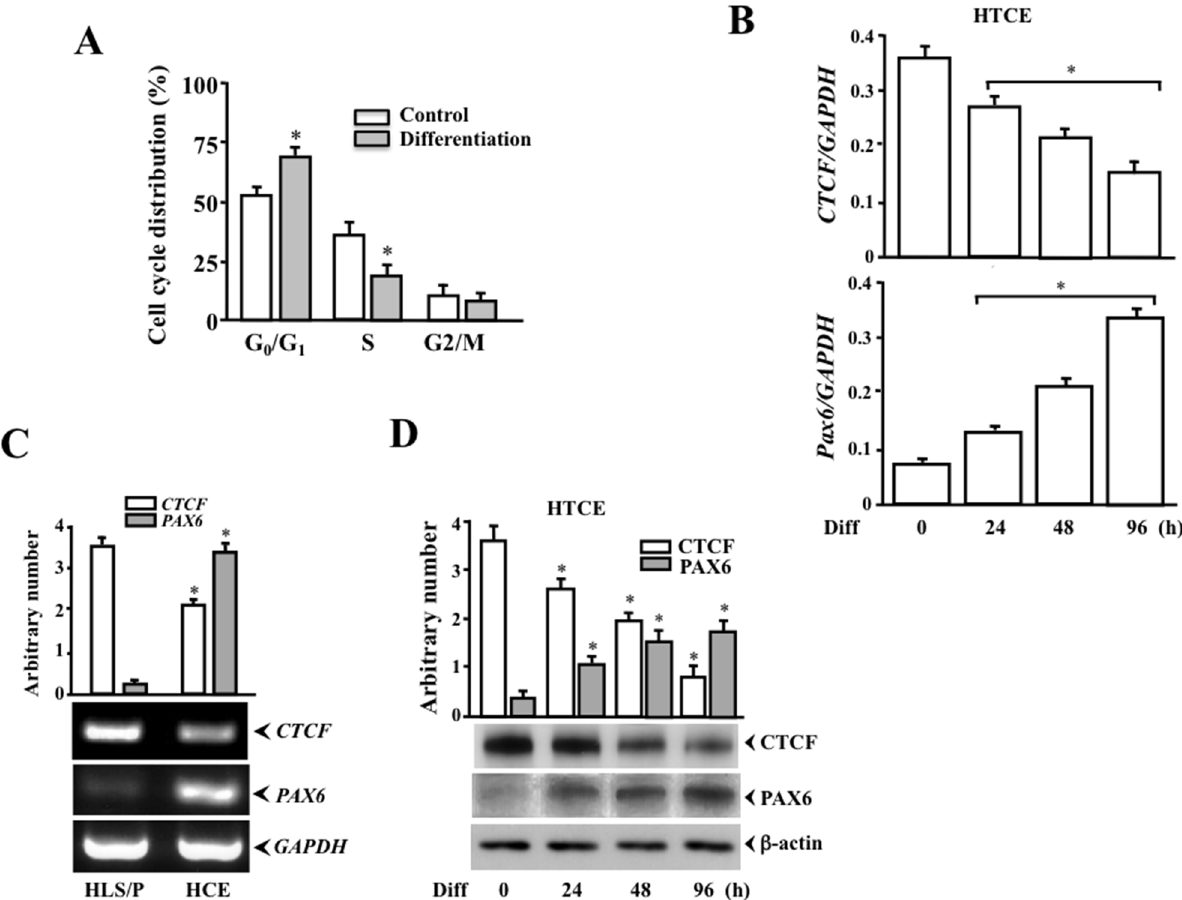
Fig 2. Correlation of CTCF and PAX6 expression during corneal epithelial cell differentiation. ( A ) Cell cycle analysis by flow cytometry revealed significantly increased and decreased cell populations in G 0 /G 1 and S phases, respectively. ( B ) Time courses of CTCF and PAX6 mRNA expressions in HTCE cell differentiation. ( C ) Detection and analysis of CTCF and PAX6 mRNA expressions in HLS/P and HCE cells. ( D ) Western analysis demonstrated that there is an opposite expression pattern between CTCF and Pax6 following a time course of HTCE cell differentiation (Diff). Flow cytometric analysis of HTCE cells with or without differentiation was performed as described in materials and methods section. Expressions of CTCF and Pax6 in both their protein and RNA levels were detected by Western blots and quantitative real-time RT-PCR during HTCE cell differentiation for as long as 96 h after induction. Symbol “ * ” indicates significant differences ( p < 0.05, n = 4).